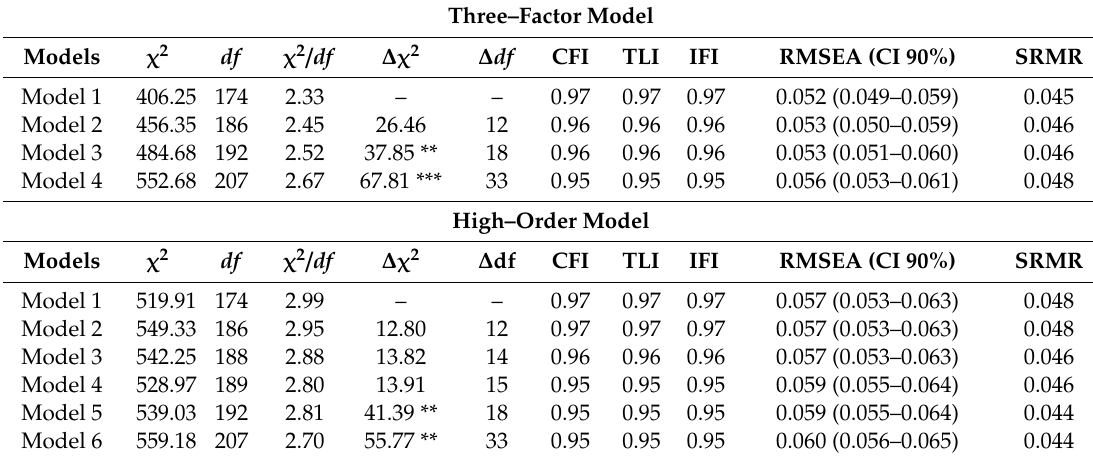
Table 4. Analysis of invariance by